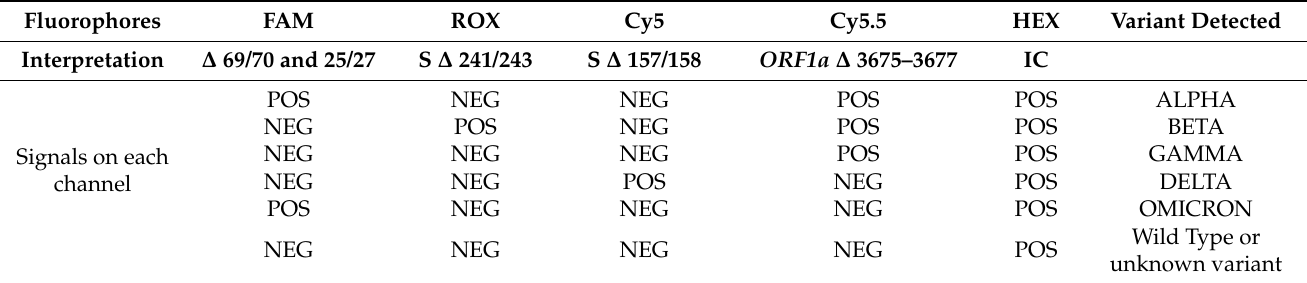
Table 2: An observed combination other than those described could indicate a new mutation or a coinfection of different